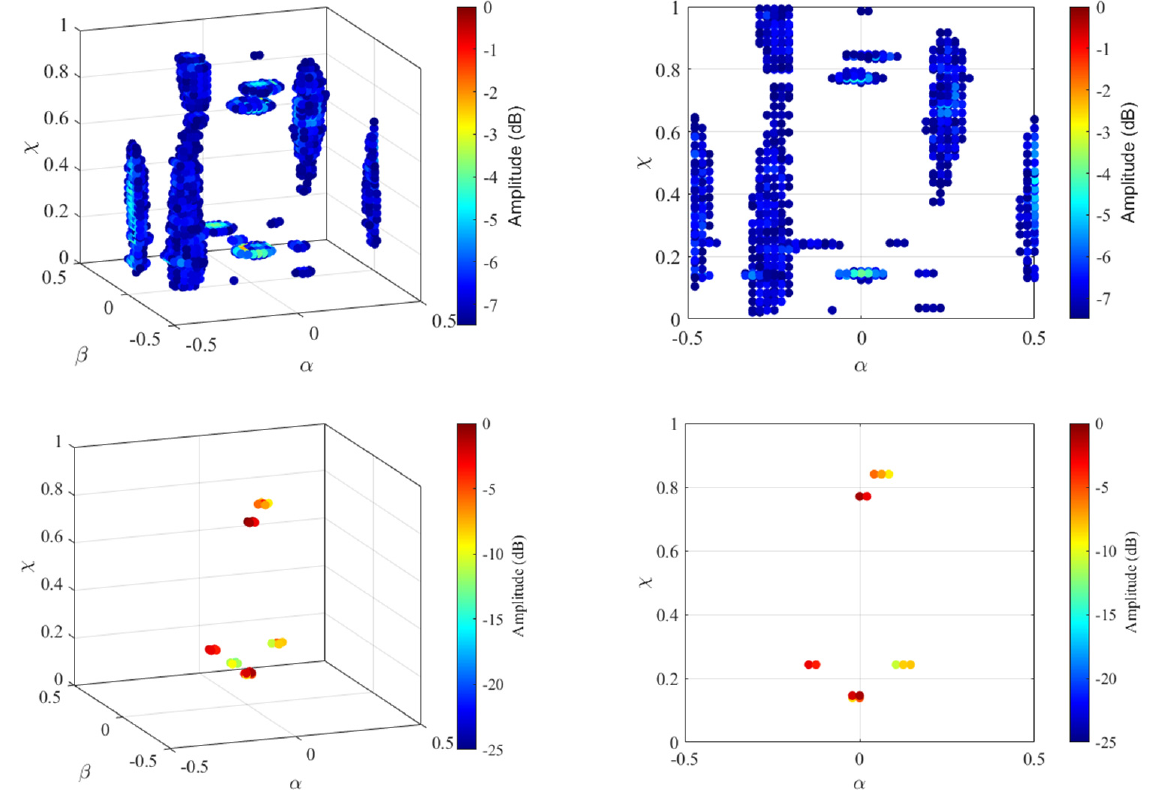
Figure 32. Real target imaging results obtained by (top) 3D IFFT and (bottom) TSL0 after WDR with ISR = 70 dB.